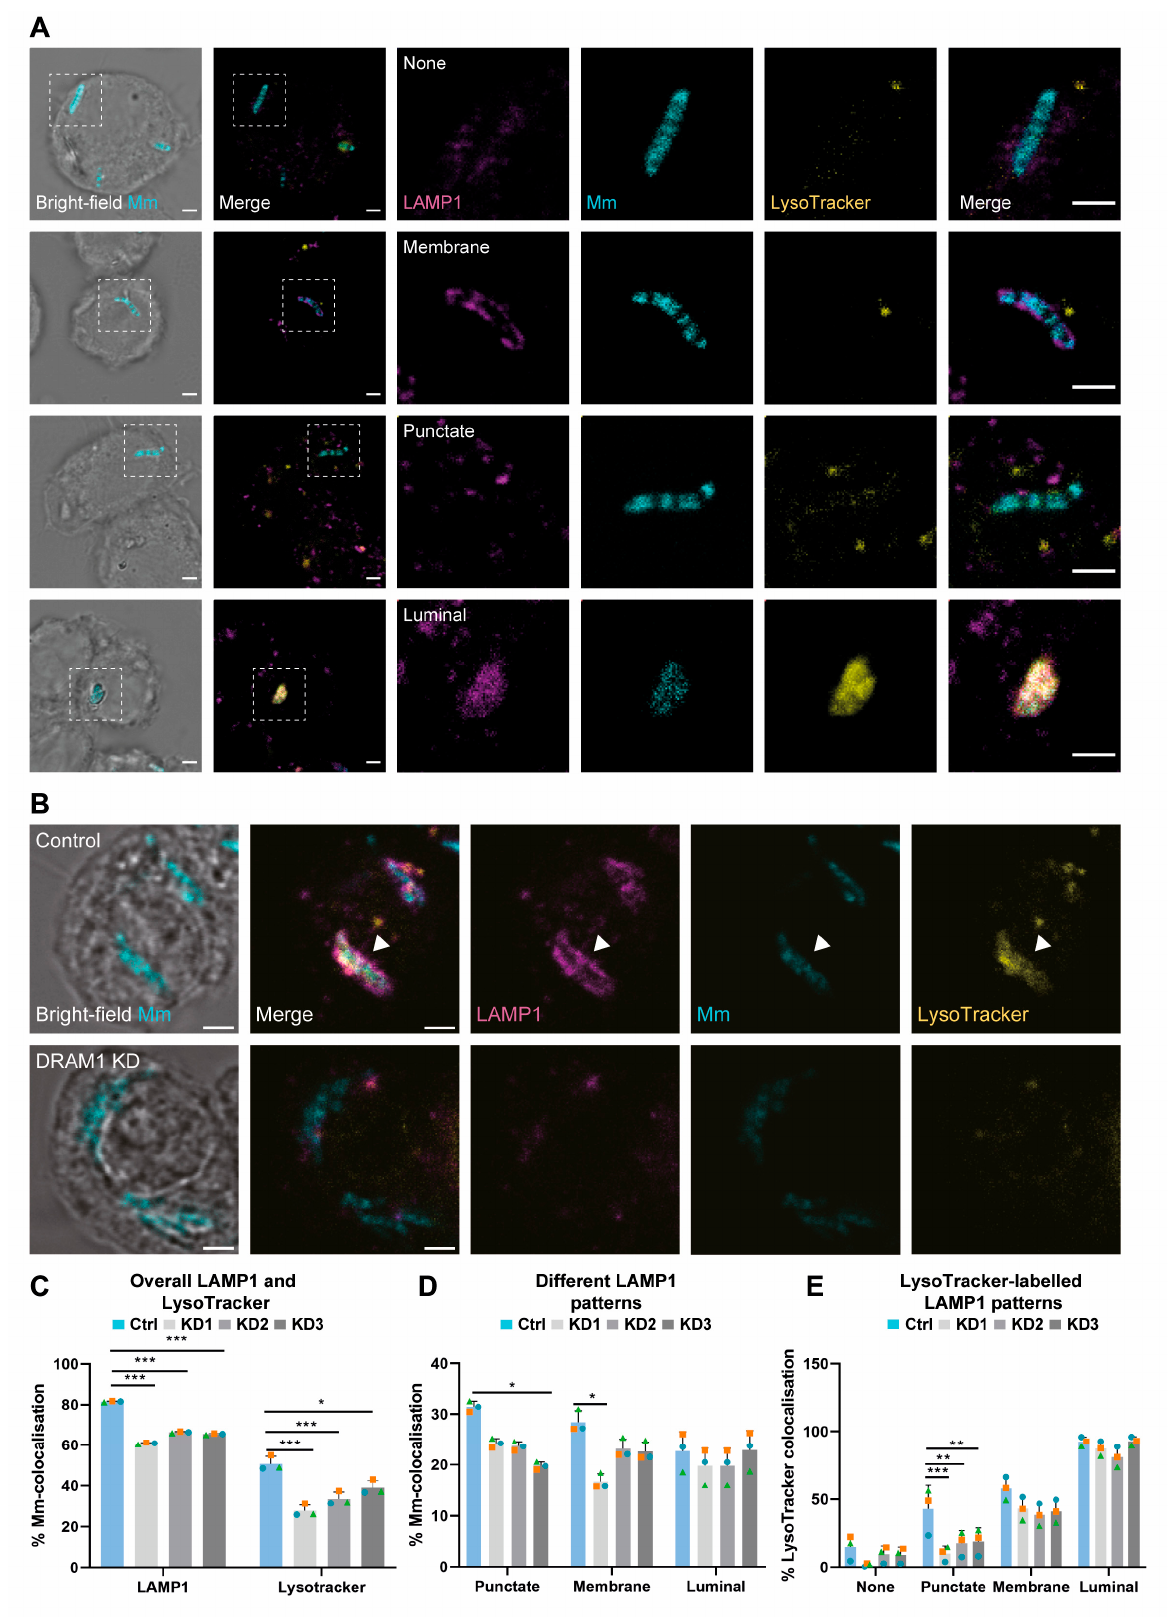
Figure 5. DRAM1 knockdown reduces LAMP1 staining of Mm -containing vesicles. ( A ) Representa- tive examples of LAMP1 (magenta) colocalisation patterns with Mm (cyan), referred to as